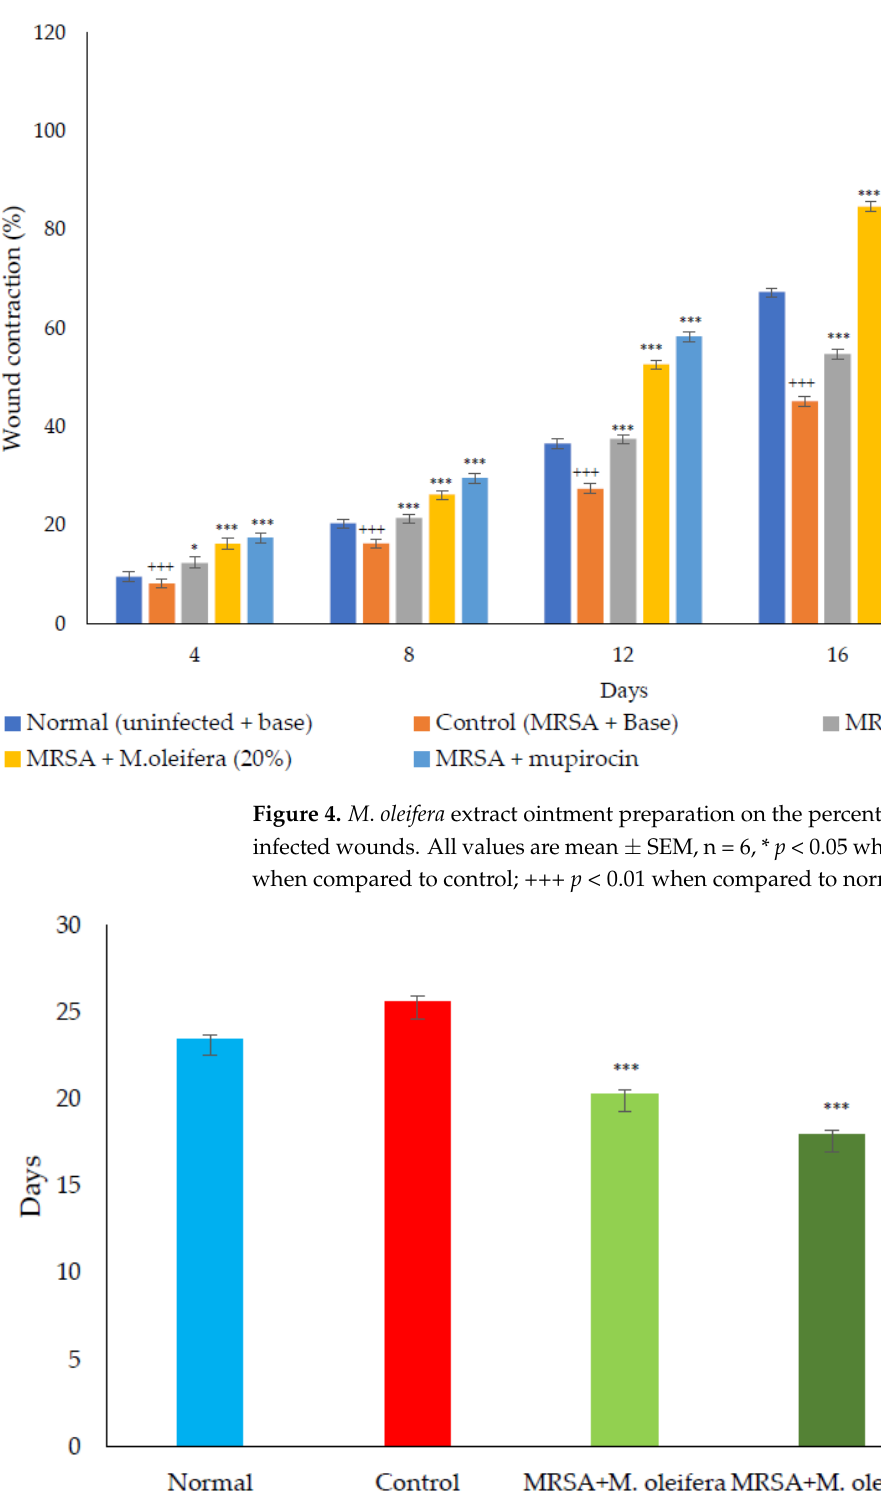
Figure 5. Epithelization period in MRSA ‐ infected wounds in rats. All values are mean ± SEM, n = 6, *** p < 0.001 when compared to control.